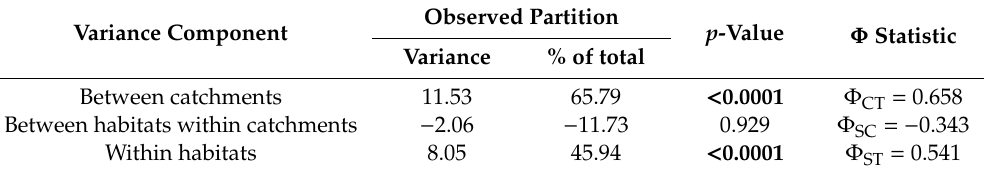
Figure 5. Phylogenetic relationships (strict consensus topology) of G. brevipinnis , G. gollumoides and G. vulgaris from sampled habitats in this study, and representatives of other lineages within the two recognised morphotypes of the G. vulgaris species complex. A minimum of two specimens were included for each habitat. Values at nodes represent parsimony bootstrap percentages (when exceeding 70%). Table 4. Results of analysis of molecular variance (AMOVA) analysis examining partitioning of Galaxias haplotype variation between and within river catchments and lentic and lotic habitat types. Bold text—significant at p <